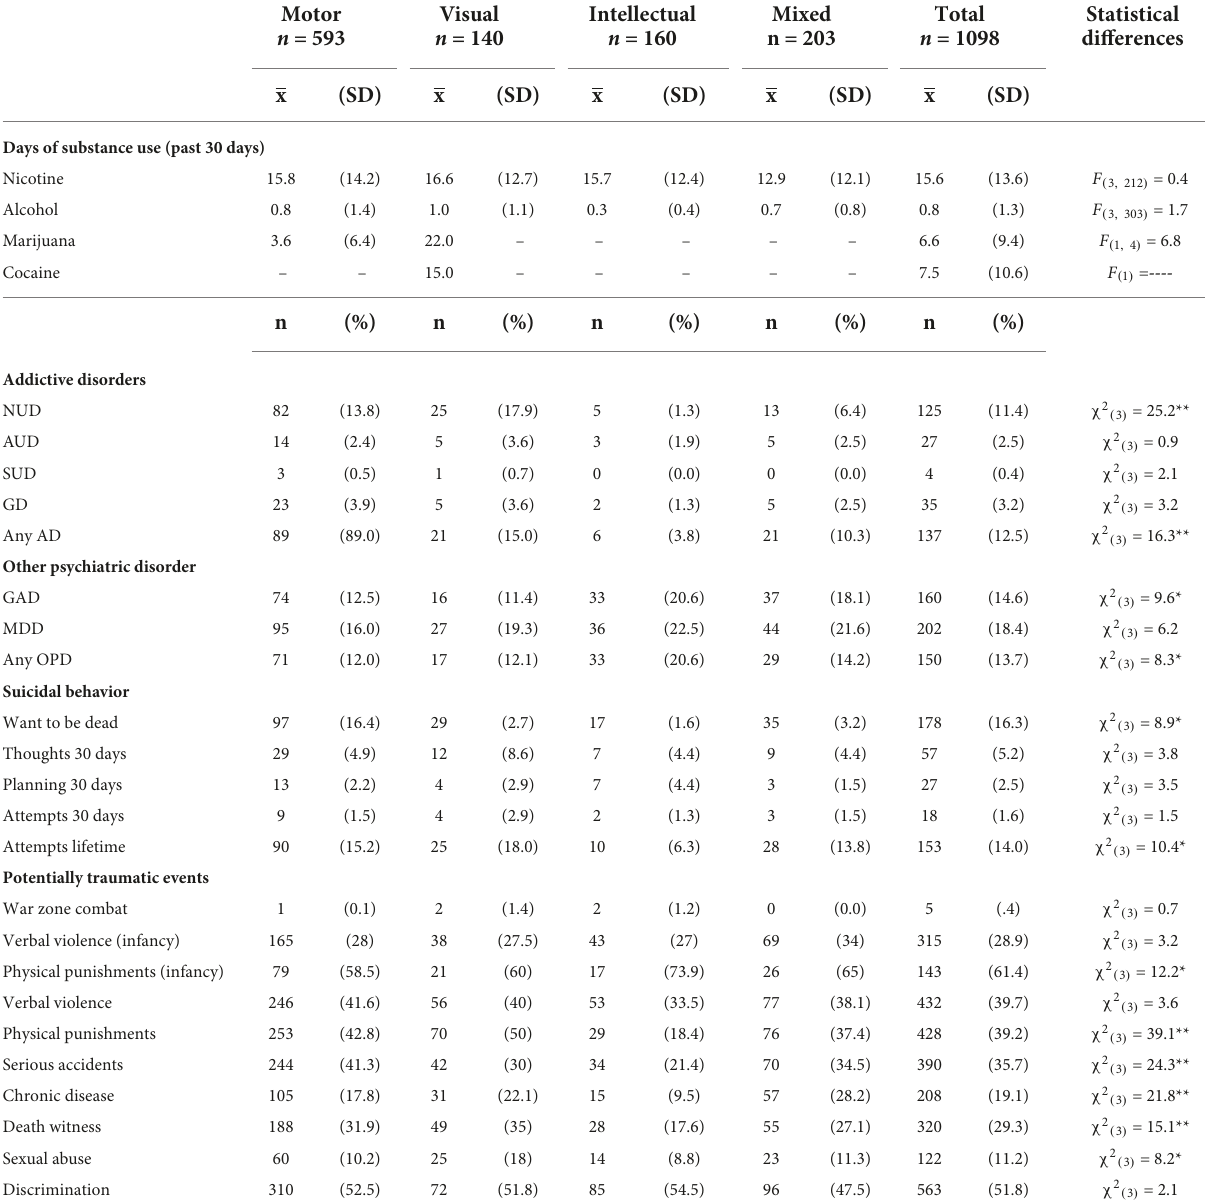
TABLE 2 Prevalence of addictive disorders, psychiatric disorders, suicidal behavior, and potentially traumatic events (PTEs) by disability